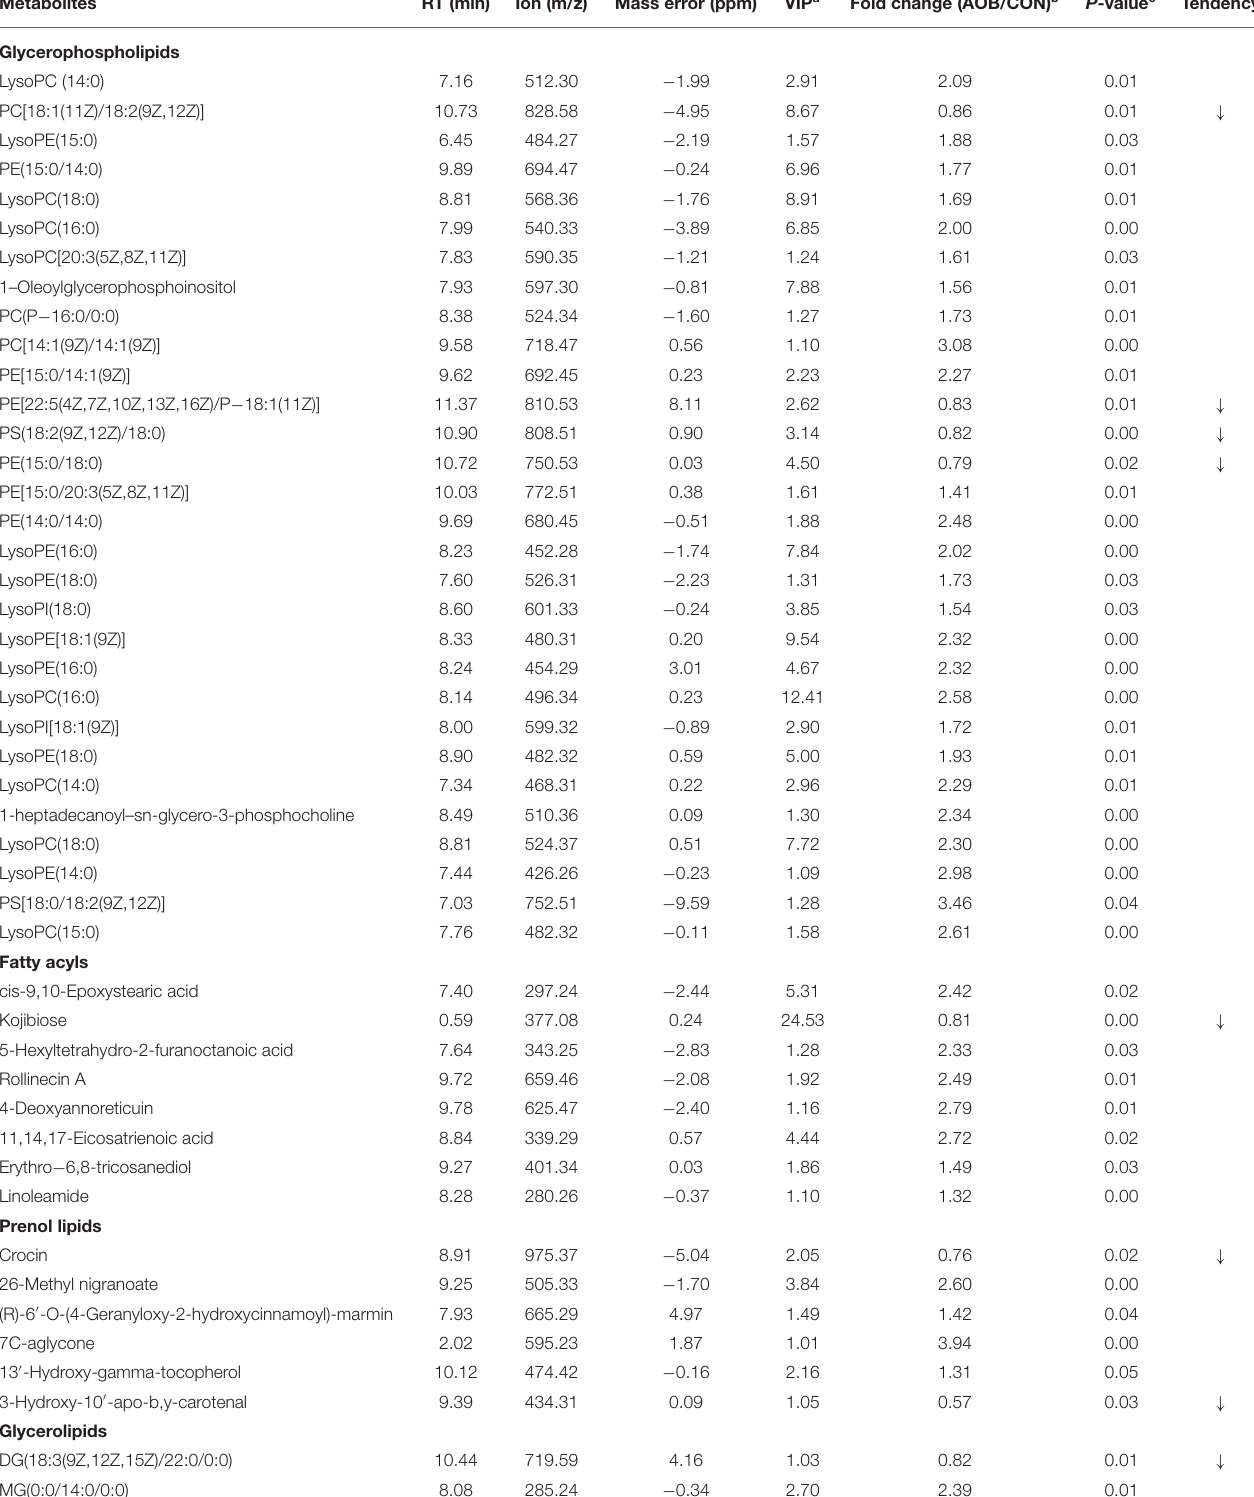
TABLE 4 | Comparison of metabolite contents of milk samples from lactating cows fed TMR with supplementation of 0 (CON) and 60 g/d of bamboo leaf extracts (AOB), n = 6. Metabolites RT (min) Ion (m/z) Mass error (ppm) VIP a Fold change (AOB/CON) b P -value c Tendency